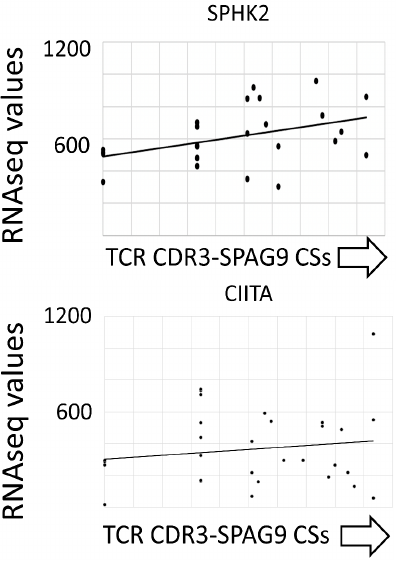
Figure 1. Kaplan–Meier (KM) analyses comparing disease-free survival (DFS) probabilities for case IDs representing the upper and lower 50th percentile TCR CDR3-CTA complementarity scores (CSs). ( A ) KM analysis of case IDs representing the upper (black line, n = 17) and lower (grey line, n = 18) 50th percentile TRA or TRB CDR3-SPAG9 CS groups. ( B ) KM analysis of case IDs representing the upper (black line, n = 19) and lower (grey line, n = 21) 50th percentile TRA or TRB CDR3-GAGE12F CS groups. ( C ) KM analysis of case IDs representing the upper (black line, n = 22) and lower (grey line, n = 22) 50th percentile TRA or TRB CDR3-GAGE12G CS groups.